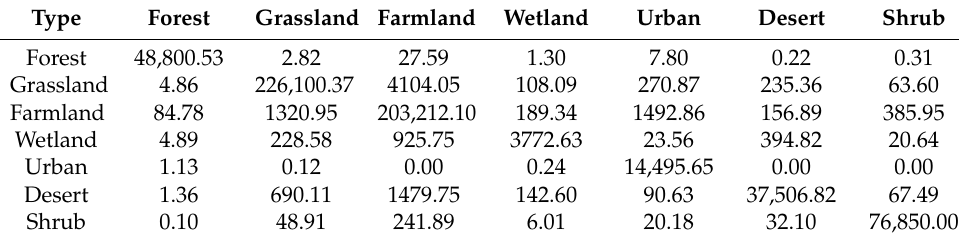
Table 4. Transfer matrix of different ecosystems from 1990 to 2000 (unit: km 2